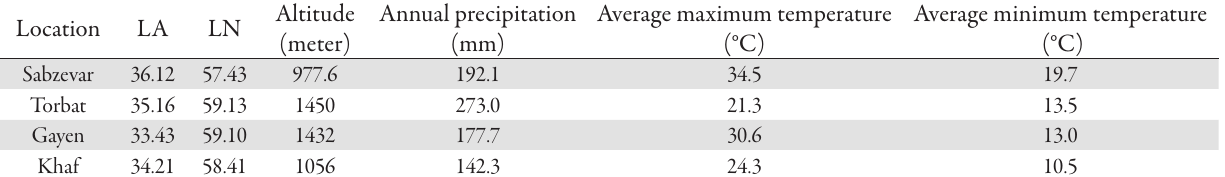
Tab. 1. Climatic features of origin regions of study ecotypes Location